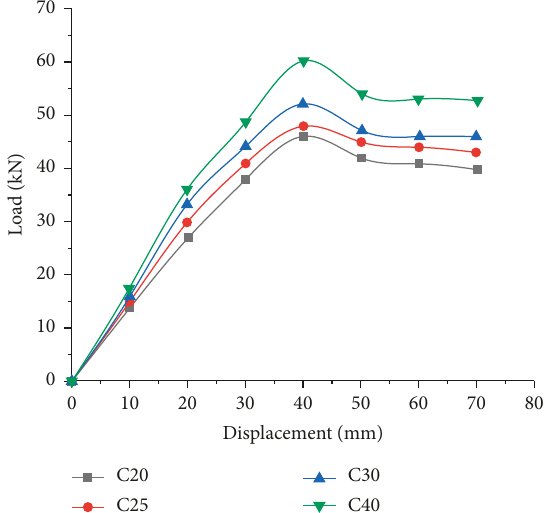
Figure 16: Load-displacement curves of joints with different concrete strength